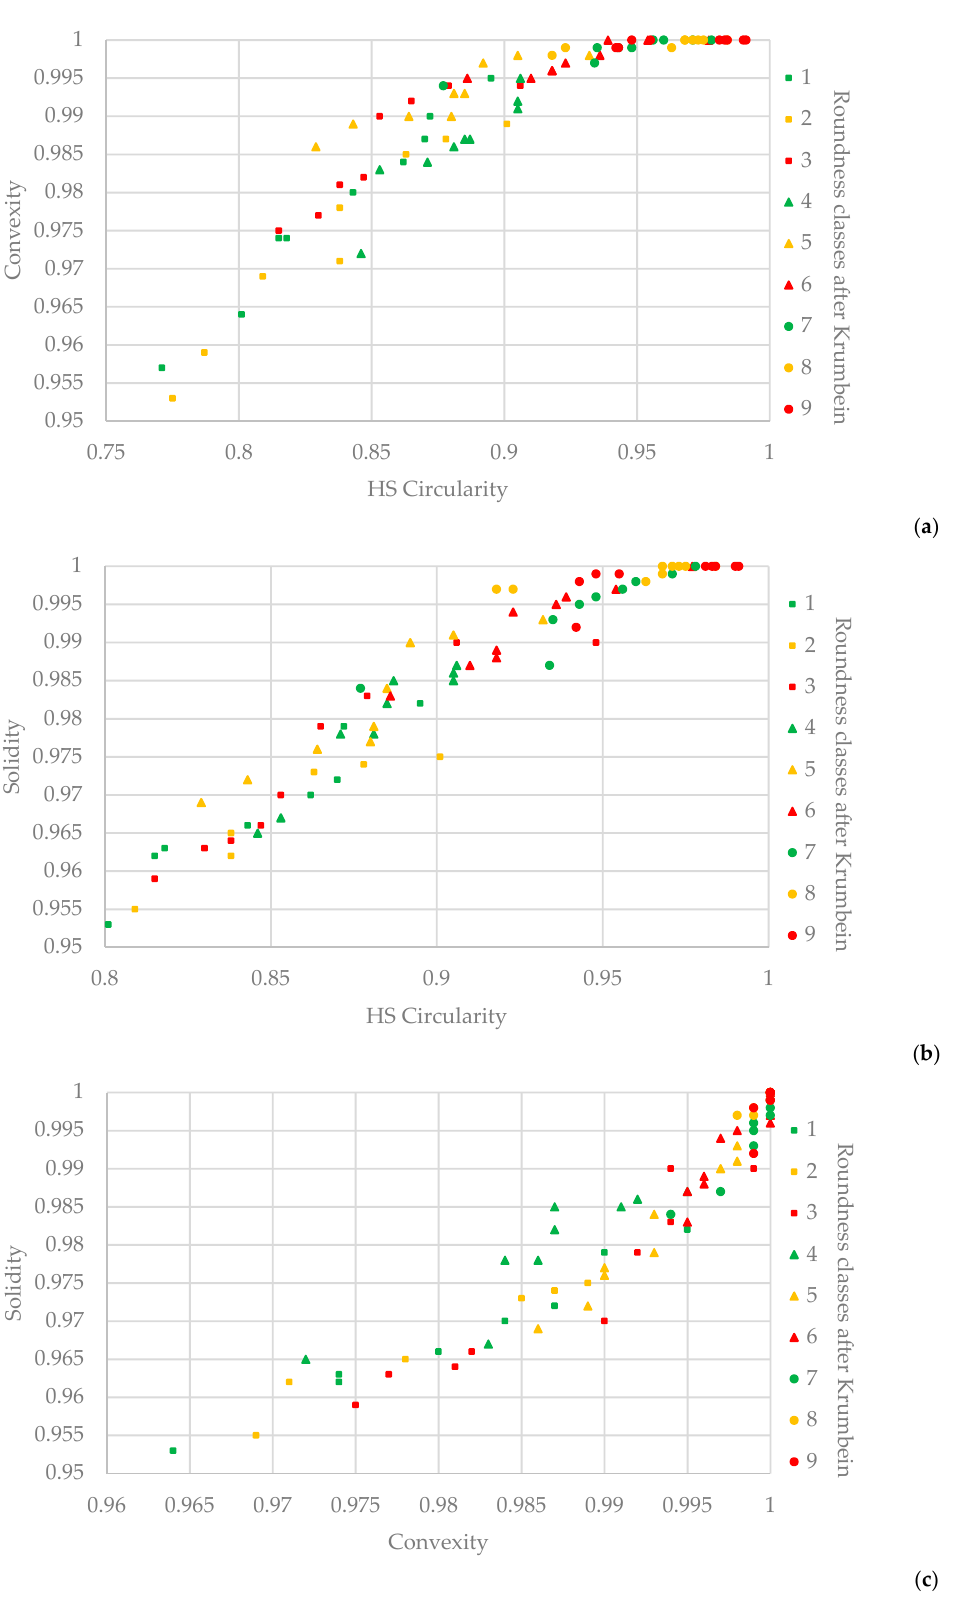
Figure 4. Diagrams of dependence of statistical parameters: ( a ) HS Circularity vs. Convexity; ( b ) HS Circularity vs. Solidity; ( c ) Convexity vs. Solidity, 1–9 Krumbein classes.